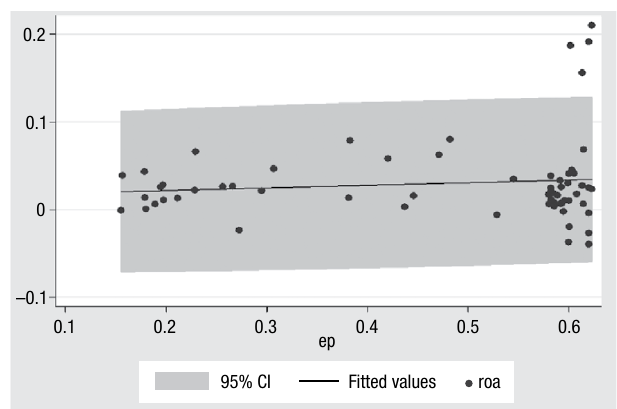
Fig. 3. ROA and Profit